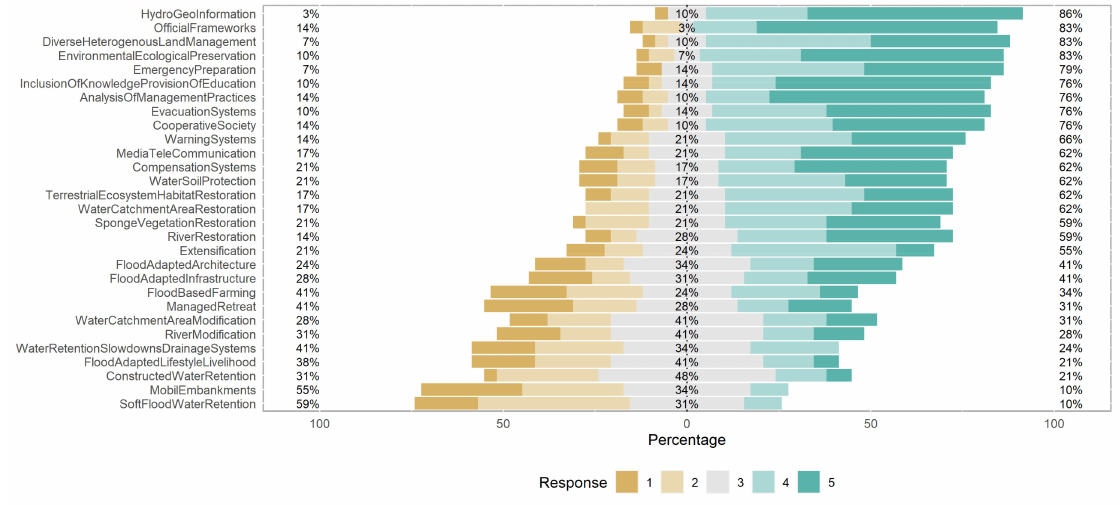
Figure A4. Percentages of Likert Scores for the applicability of flood measures from 1 being rarely applicable to 5 being totally applicable to rural mountain